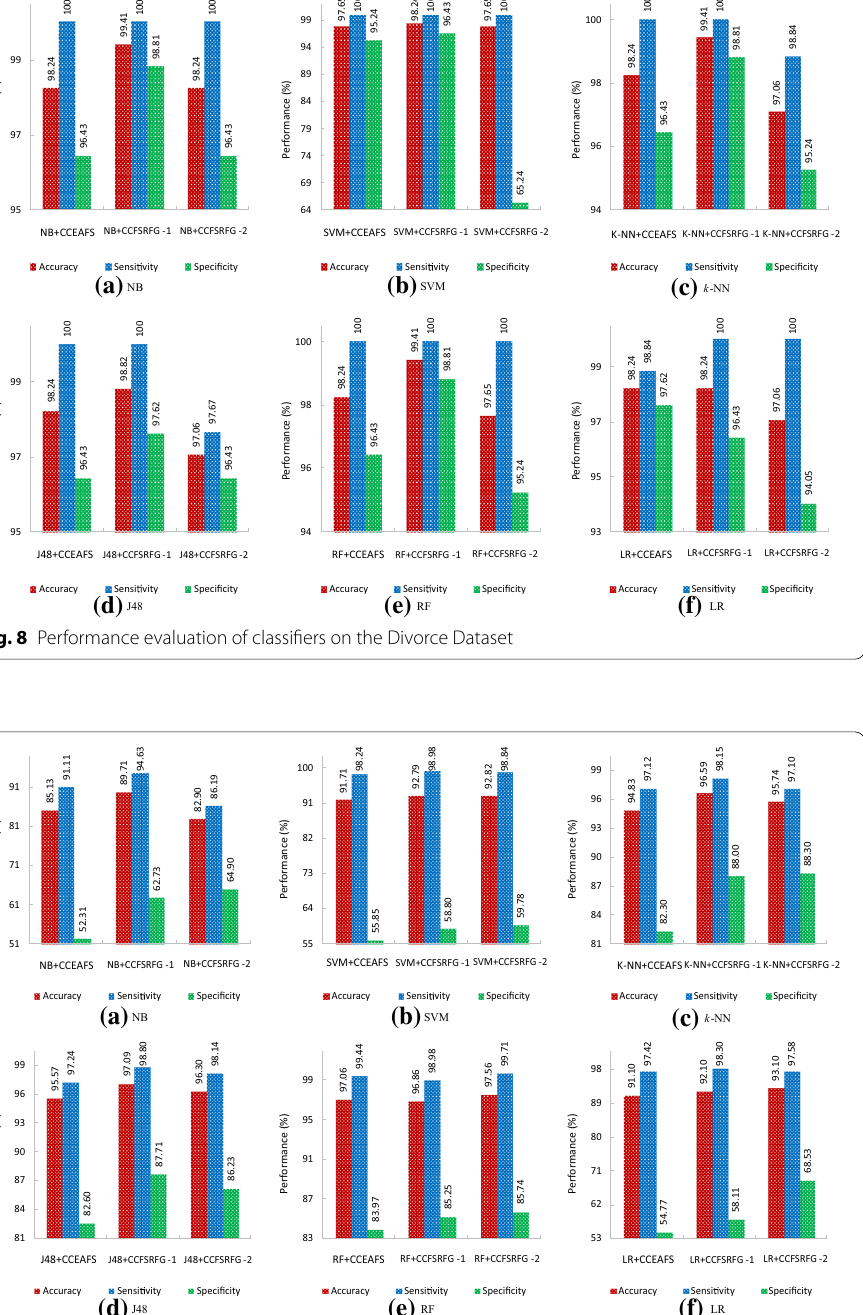
random collaboration was performed to collaborate with individuals from other subpop- ulations. Collaboration performance, i.e., the fitness value was assigned to the individual being evaluated. The best individuals were combined from all subpopulations to obtain the best individual in a generation. To evaluate an individual in any subpopulation, the